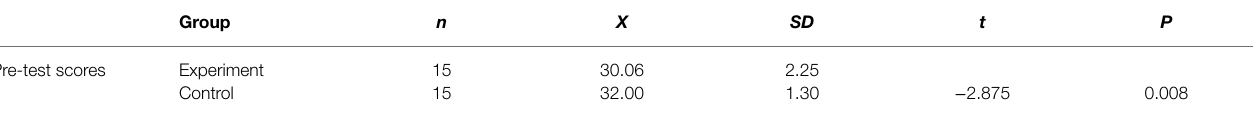
TABLE 3 | Examination of school burnout pre-test scores according to experimental and control groups. Group n X SD Pre-test scores